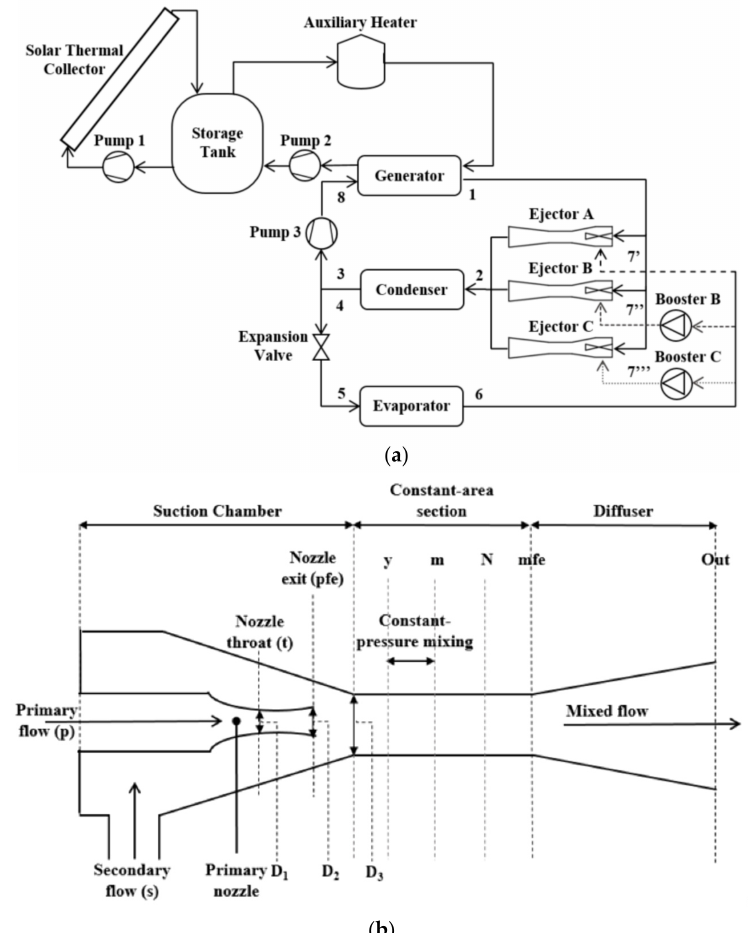
Figure 1. Schematic representation of the solar compression-assisted, triple parallel ejector refrigeration system: ( a ) system layout; ( b ) schematic ejector geometry. D 1 , D 2 , and D 3 refer to the effective area diameters of the ejector nozzle throat, nozzle exit, and mixing chamber,